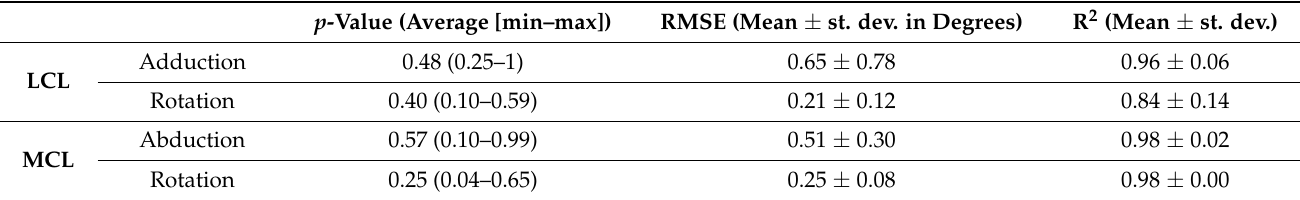
Table 1. Comparison of the unconstrained kinematics between the digital image correlation (DIC) and ultrasound (US) acquisitions. Average p -values across the loading range are reported with minimal and maximal values ( p -values < 0.05 in red). Root mean square errors (RMSE) are expressed as the means across the loading range ± standard deviations in degrees. The linear correlation coefficient (R 2 ) is reported as the average overloading range ± standard deviation. LCL: lateral collateral ligament and MCL: medial collateral ligament.